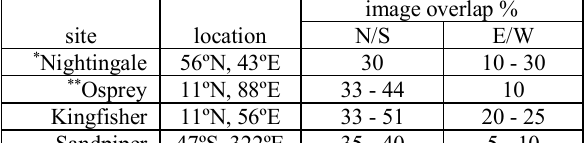
Table 3: Locations and approximate image overlaps for the final four candidate sample sites (single and double asterisks indicate the selected primary and secondary sample sites respectively).